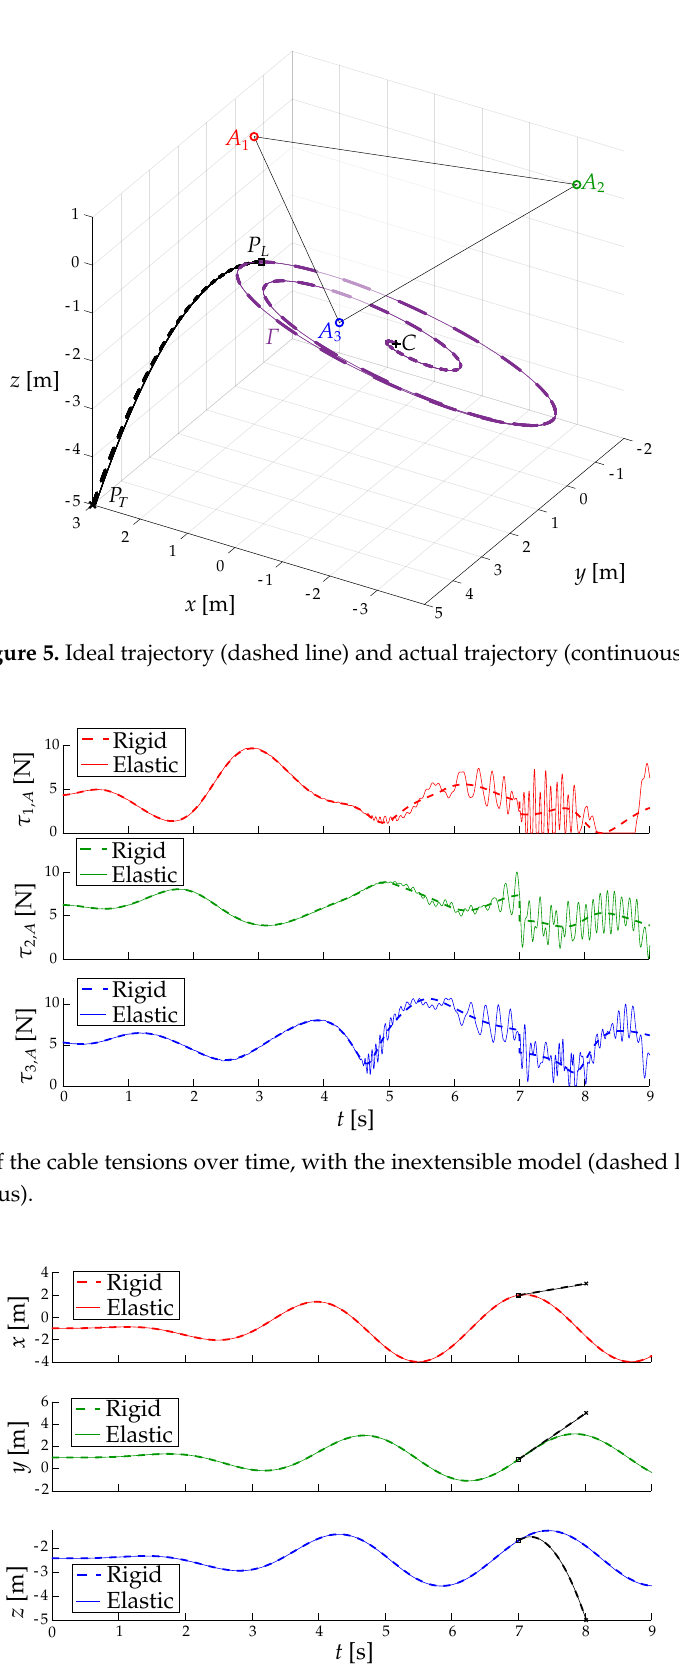
Figure 7. Coordinates of the end-effector (EE) (in color) and of the launched object (black) with both models, along the three